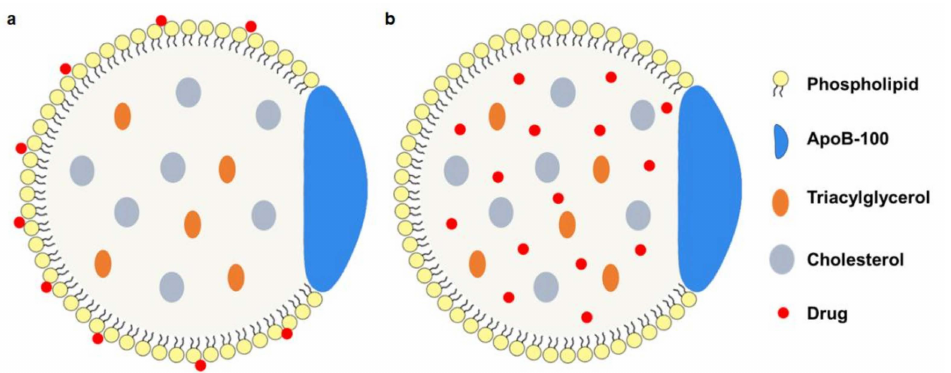
Figure 3. The modification strategy of nLDL-drugs particles. ( a ) drugs are inserted in the phospho- lipid monolayer; ( b ) drugs are loaded to the hydrophobic